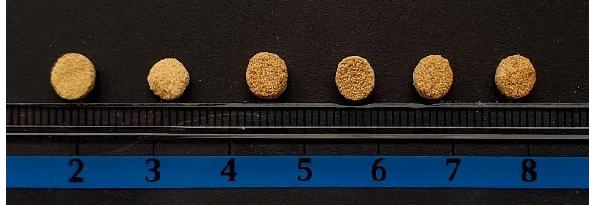
Figure 2. Photographs of the selected SLS-printed tablets with irbesartan. Tablets were printed with different laser speeds. From left to right: 100.00 mm/s, 120.00 mm/s, 140.00 mm/s, 160.00 mm/s, 180.00 mm/s, and 220.00 mm/s.